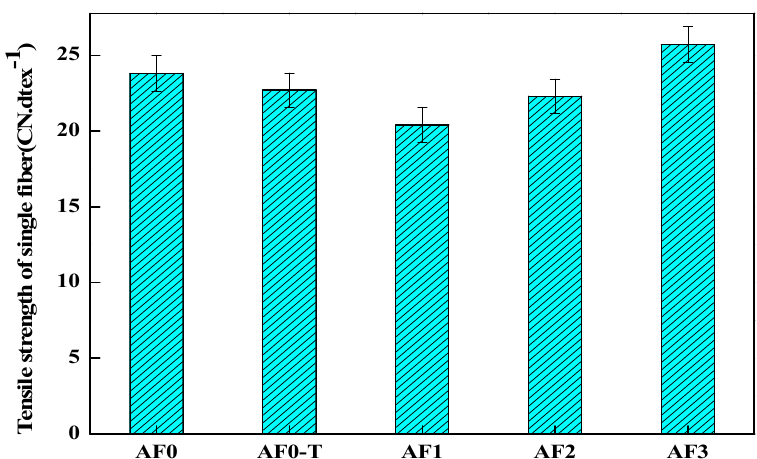
Figure 13. Tensile strength of aramid fiber before and after processing.